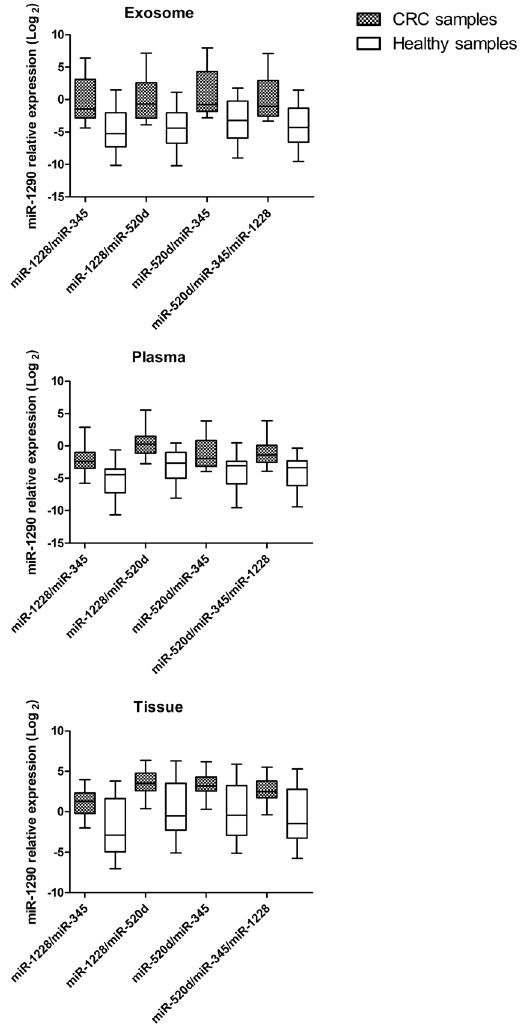
Figure 3. Effect of reference gene choice on relative expression of target miR-1290. By using different combinations of selected reference miRNAs the difference in miR-1290 expression between CRC and control samples always resulted significantly different (p < 0.005 for